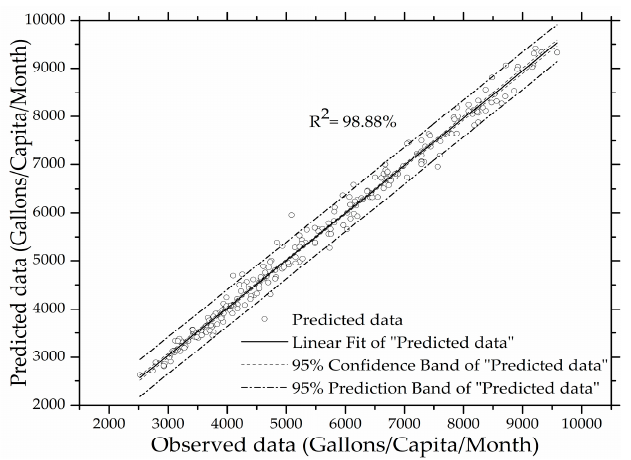
Figure 6. Water consumption plot between observed and predicted data with 95 percent confidence interval using ARIMAX with dew point depression model. After trial and error with autoregressive and moving average parameters, the final model result for the individual meteorological factors using Equation (4) yielded the lowest AIC value (Table 2). The parameter estimates for each ARIMAX model are shown in Table 3. Table 3. Parameter estimates of the model fittings and standard errors (in parentheses) results for the transfer function-noise model (ARIMAX) during 1990–2009.